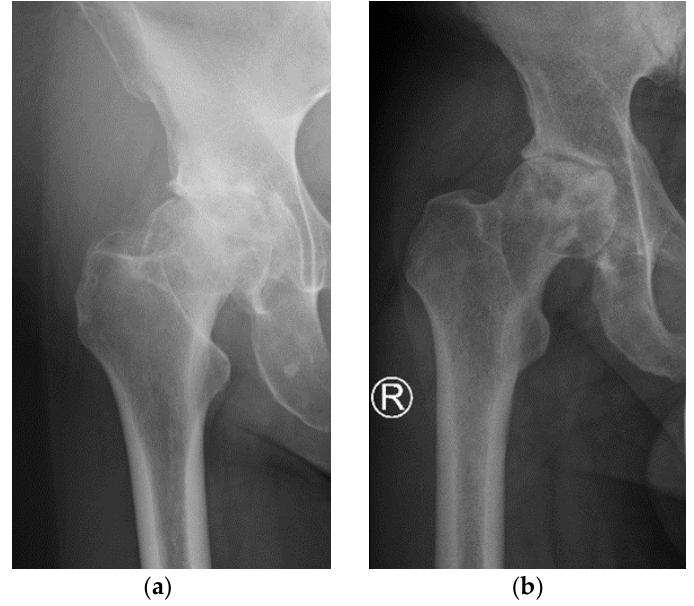
Figure 3. Pre-operative AP X-Ray right hip joints of two patients: ( a ) patient 2; ( b ) patient 4.